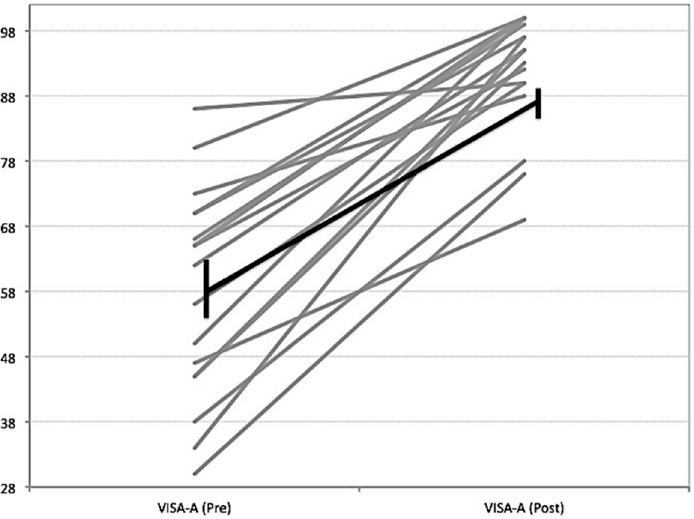
Figure 2. Individual VISA-A responses pre- and post-surgery (24 months) (in grey). The average improvement is indicated by the black line.